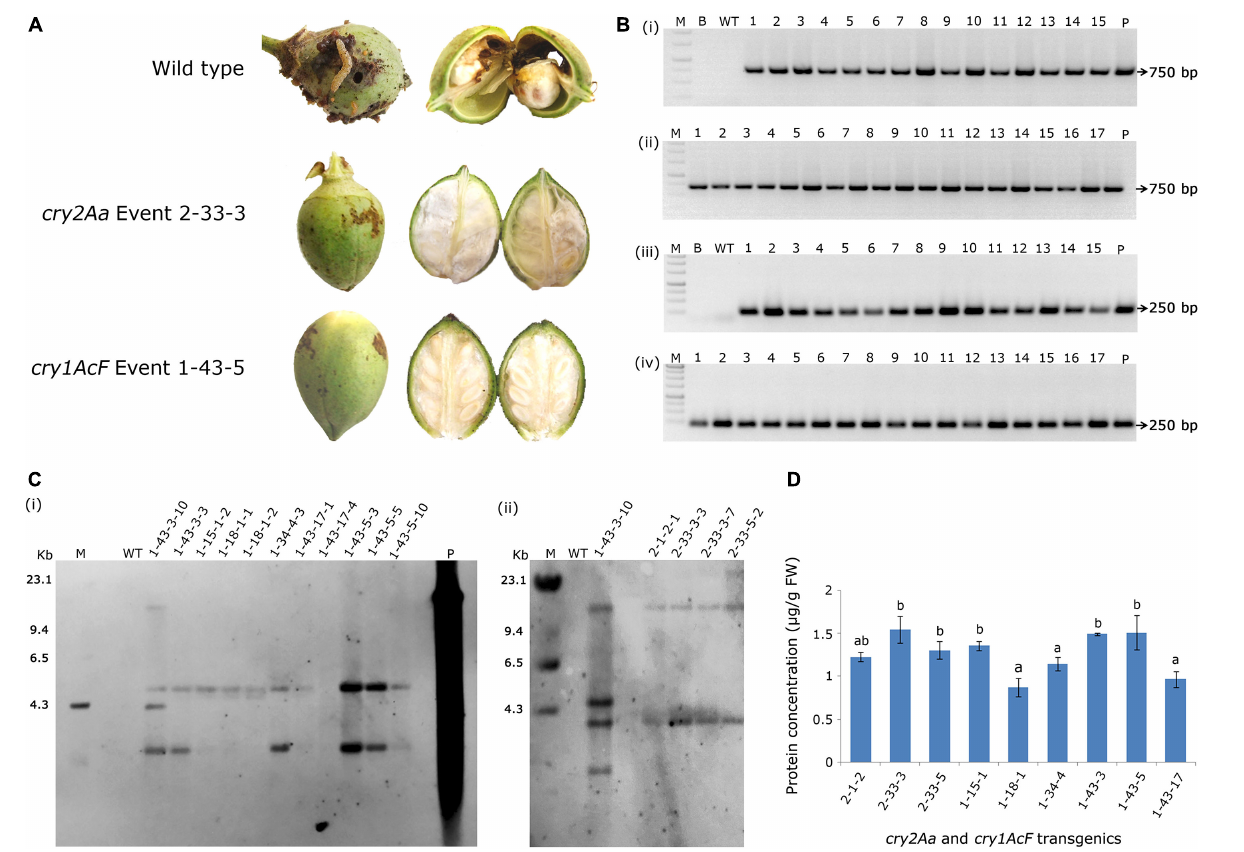
FIGURE 9 | Assessment of bolls of cotton transformants to Helicoverpa armigera challenge and molecular characterization of superior transgenic events. (A) Representative bolls of wild type and transgenic events, and (B) PCR analysis of T 3 generation progeny plants for the amplification of (i,ii) 750 bp nptII gene and (iii,iv) 250 bp T-DNA right border specific fragments. Lane M – 1 Kb Ladder (Thermo Scientific), Lane B – Water Blank (all PCR components but without template DNA), Lane WT – wild type (100 ng), Lanes 1–15 of (i,iii) and Lanes 1–17 of (ii,iv) represents: four progeny plant of events–2-1-2, 2-33-3, 2-33-5, 1-15-1, 1-18-1, 1-34-4, 1-43-3, and 1-43-5. Lane P–positive control (binary vector) pBinAR cry1AcF . (C) Genomic Southern analysis of transgenic plants probed with 750 bp DIG-labelled nptII gene (i) transgenic cotton plants with cry1AcF and (ii) transgenic cotton plants with cry2Aa . Lane M – Lambda Hin dIII DNA ladder, Lane P